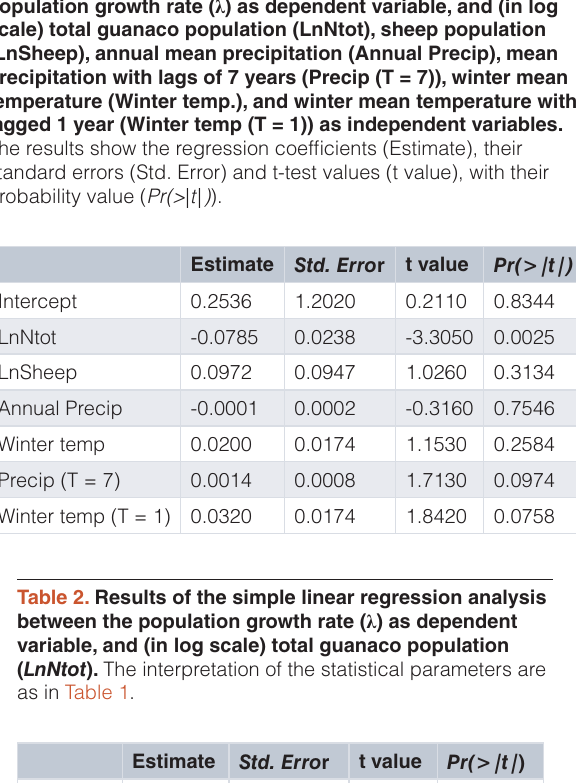
Table 1. Results of multiple regression analysis between the population growth rate ( λ ) as dependent variable, and (in log